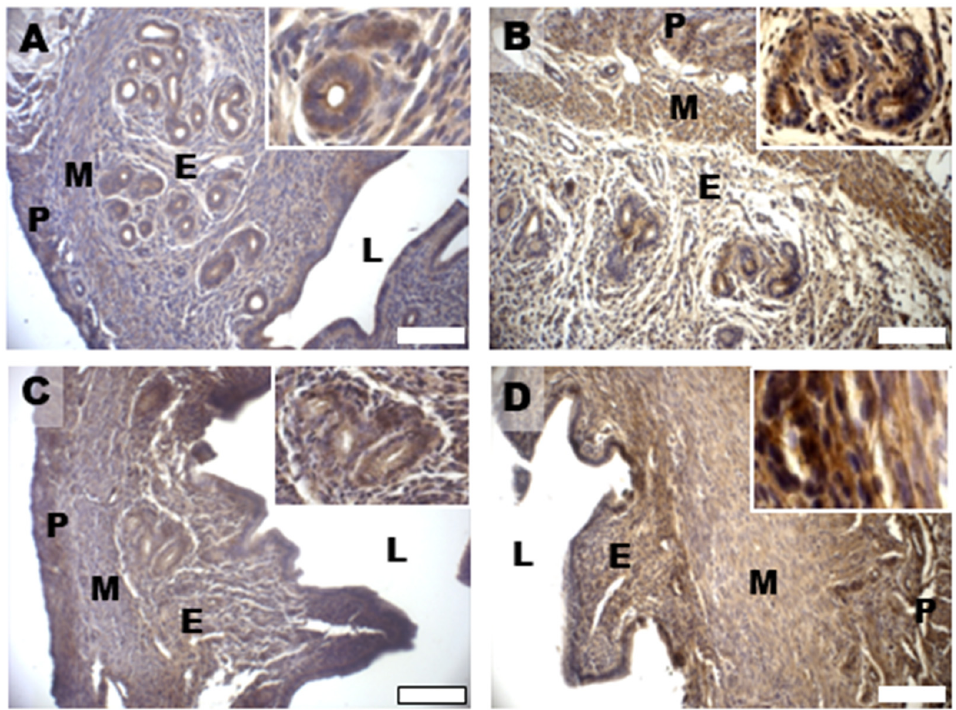
Figure 11. Immunostaining of mouse uterine horns for MG-AGE ( A – D ) of control ( A ), DHEA ( B ), DHEA/LC-ALC ( C ) and DHEA/LC-ALC-PLC ( D ) groups. Insets show details of the glandular epithelium. L: lumen; E: endometrium; M: myometrium; P: perimetrium. LM, mag. 10 × . Insets: 20 × .